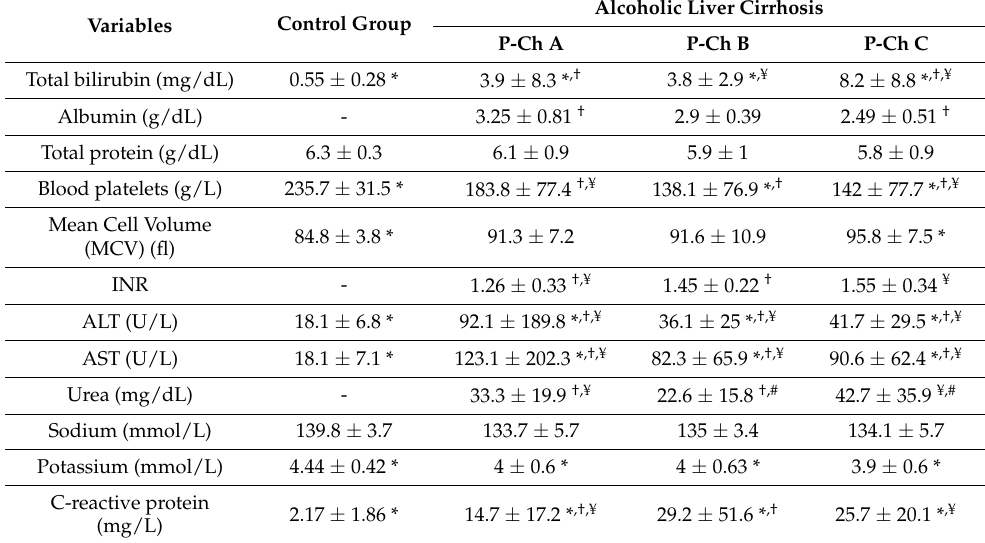
Table 2. Biochemical characteristics of the study and control groups (mean ±